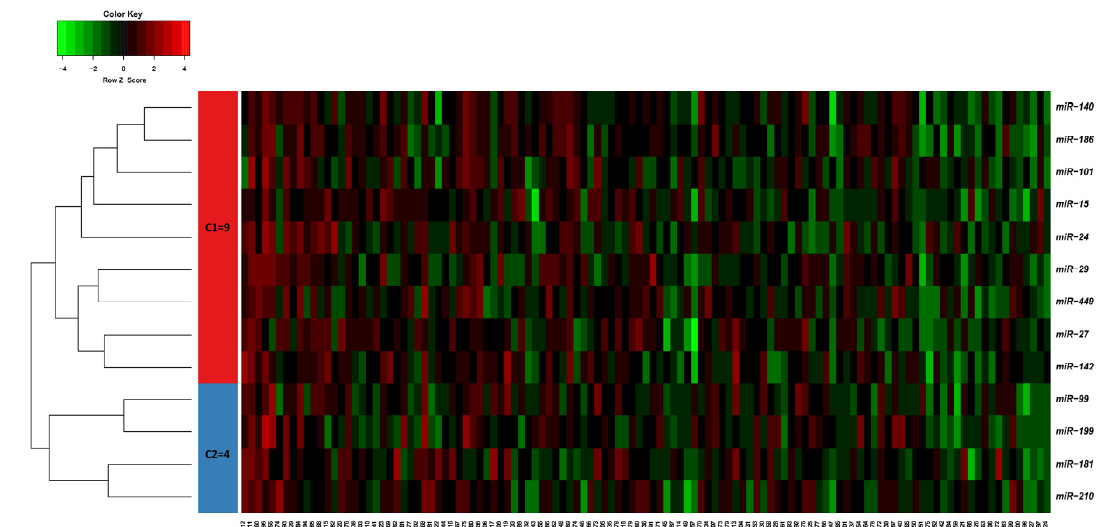
Figure 1. Heatmap of miRNAs significantly correlated to fetal weight (FDR < 0.05) in LDM of 118 pig fetuses at 63 dpc. Heatmap of the miRNAs expression profiles was generated using the hierarchical clustering method of heatmap.2 function of gPlots package (version 3.0.1) in the R programing environment (version 4.0.3) [29]. A total of 13 miRNAs correlated to fetal weight were distributed in two clusters based on their co-expression with cut-off criteria of variance-stabilizing transformations ≥ 2, |logFC ≥ 1|. In the color key, the red color represents high expression, the green color represents low expression, and the black color represents no change in